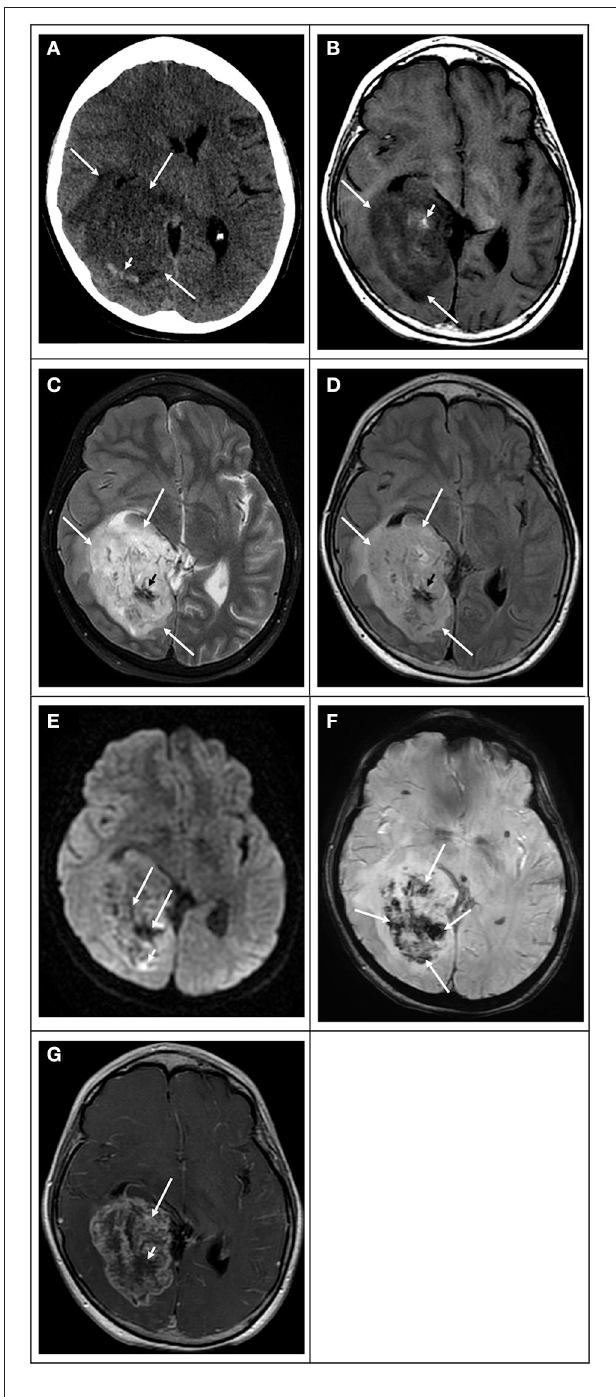
FIGURE 2 | Radiation-induced secondary “glioblastoma” in a 17-year-old girl who had a previous posterior fossa ependymoma at age 5. (A) Computed tomography image in the axial plane shows a large ill-defined tumor in the right temporal and occipital lobes (white arrows), causing mass effect, compression of the right lateral ventricle, and midline deviation. The lesion is associated with vasogenic edema and hemorrhage (white arrowhead). (B) T1 weighted image in the axial plane shows that the bulk of the lesion is hypointense (white arrows) with scattered hyperintensity foci due to intratumoral